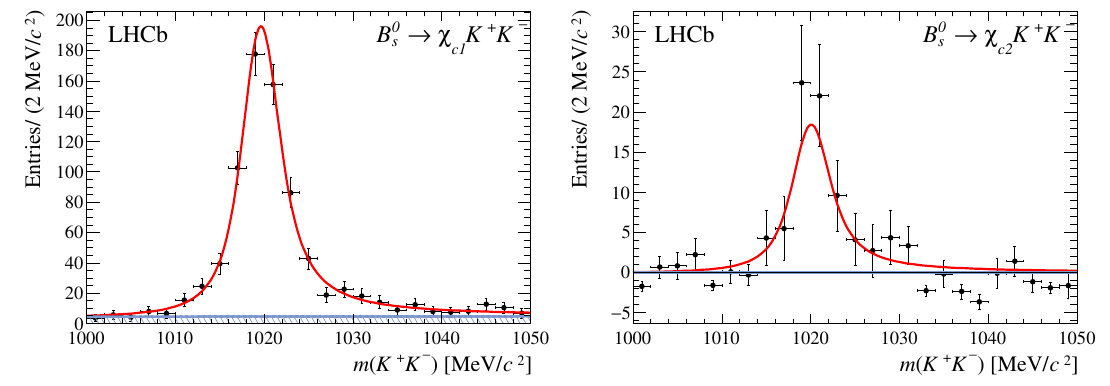
0 + K ! (cid:31) (cid:0) pair for the (left) B (cid:0) decay c 1 K s candidate invariant mass and (right) s 0 candidate invariant s